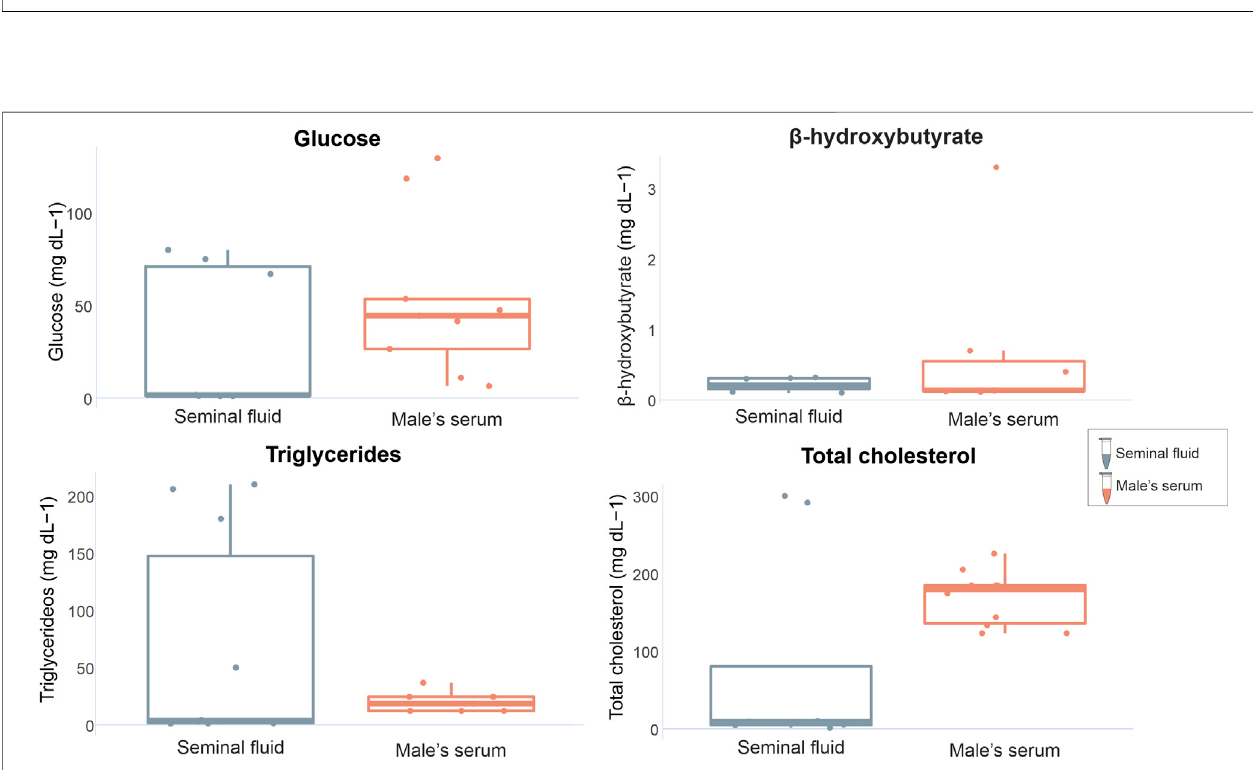
FIGURE 4 | Graphical representation of P. horkelii energetic marker concentrations in the seminal fl uid (SF) (grey boxplots) and serum of sexually active males (during the copulation phase) (light pink boxplots).